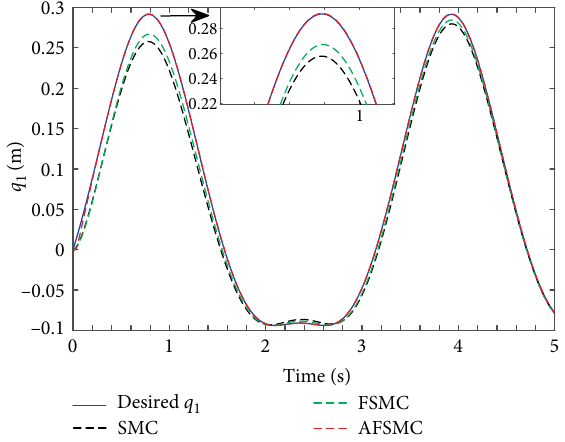
Figure 13: The tracking response of the first limb q of three 𝛼